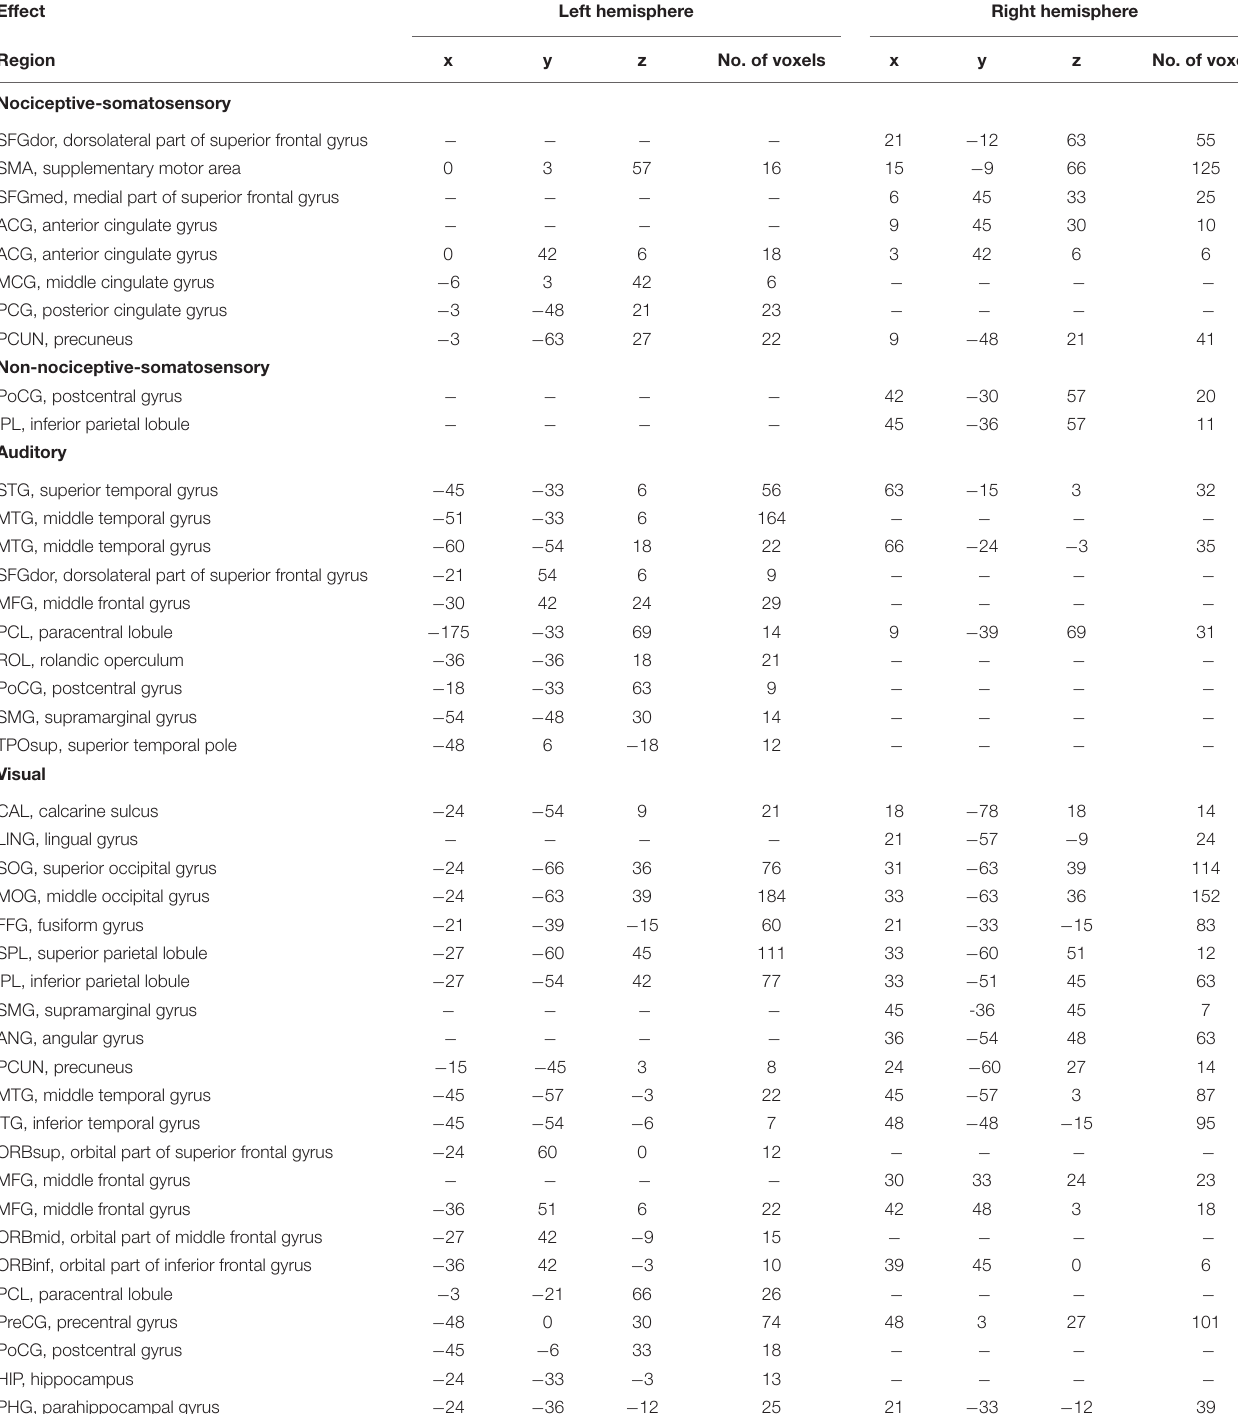
TABLE 1 | List of Modality-specific brain regions as revealed by General Linear Model (GLM). Effect Left hemisphere Right